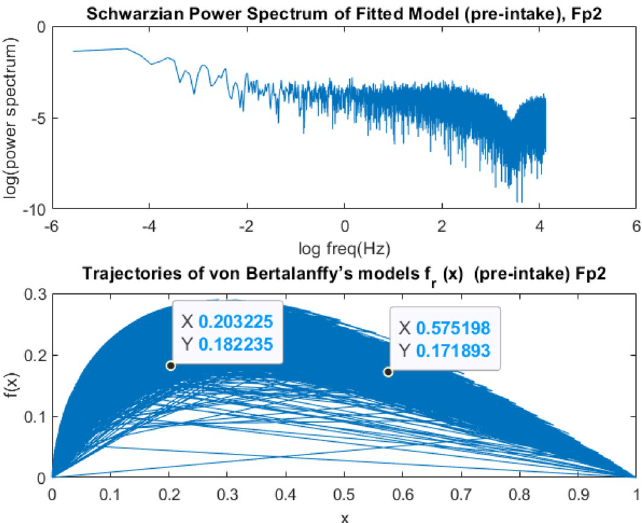
Figure 11. Power Spectrogram of Schwarzian coupling and von Bertalanffy’s EEG Phase Growth Model before medication for Fp2 electrode for an interval of 30,000-time points of T = 500 time points for each segment at fs = 125